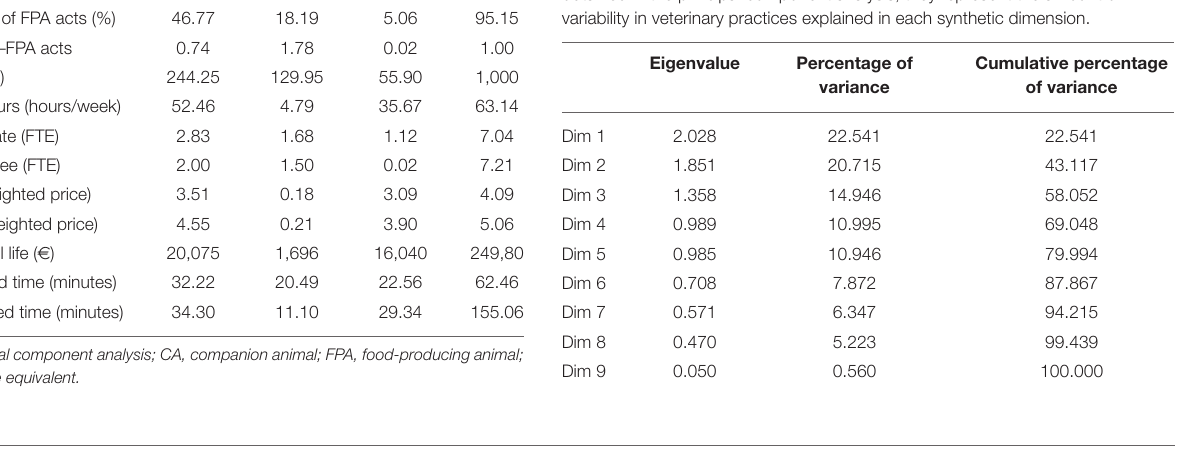
TABLE 3 | Summary statistics of qualitative variables (characteristic of the veterinarians